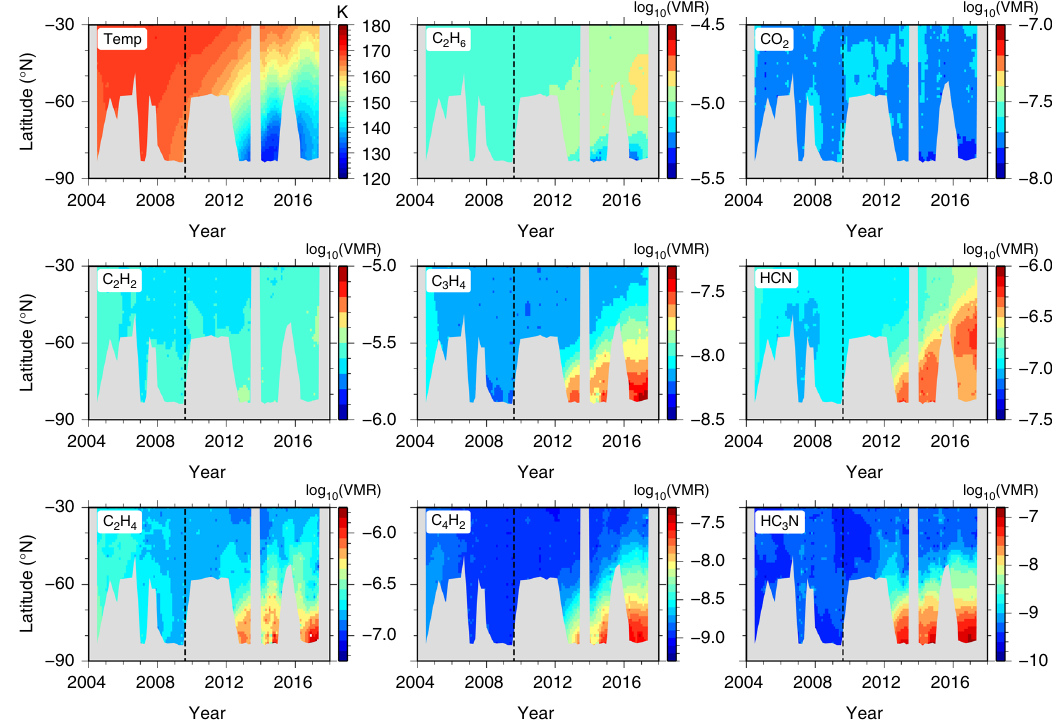
Fig. 6 Temperature and composition evolution of the south polar region derived from nadir data. Results are shown for the 1 mbar pressure level (mid- stratosphere). The polar region exhibits signi fi cant cooling, which is accompanied by extreme trace gas enrichment, particularly for short lifetime species (HC 3 N and C 4 H 2 ). The horizontal vortex size increases from ~75 – 90°S in 2012 to ~60 – 90°S in 2016. Grey areas indicate data